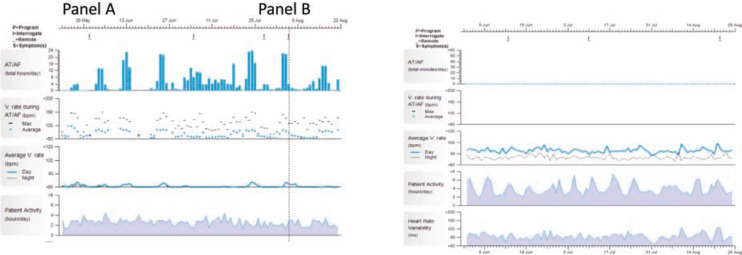
ICM findings from two patients with AF and CHA2DS2VASC scores of 3. These panels show the results of three-to-four months of continuous monitoring with ICMs in two patients with a history of AF. a: ICM tracings from a 68-year-old female with a history of hypertension (CHA2DS2VASC score = 3). The patient had numerous AF episodes lasting up to several days in duration (blue columns, top row). b: ICM tracings from a 68-year-old female with a history of hypertension (CHA2DS2VASC score = 3). The patient underwent AF ablation and had no AF over the monitoring period. Under current standards of care, both patients would be recommended to receive chronic oral anticoagulation. Abbreviations: AF: atrial fibrillation; CHA2DS2VASC: congestive heart failure, hypertension, age ≥75, diabetes mellitus, prior stroke or transient ischemic attack, vascular disease, age 65−74 years, sex; ICM: implantable cardiac monitor.